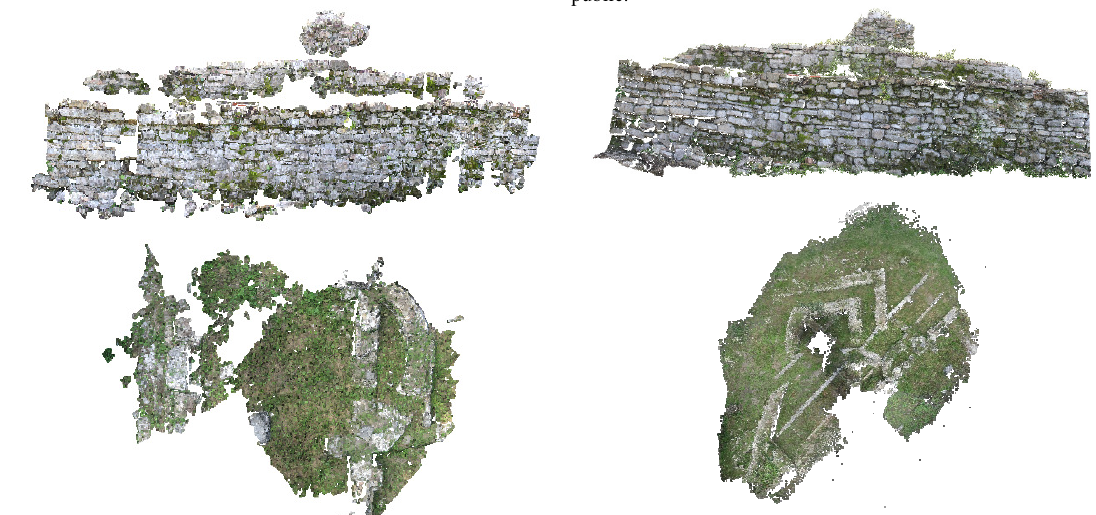
Figure 4. VisualSfM (left) and Agisoft (right) results for the wall and UAV images. Visible holes and non-reconstructed areas are present in the SfM